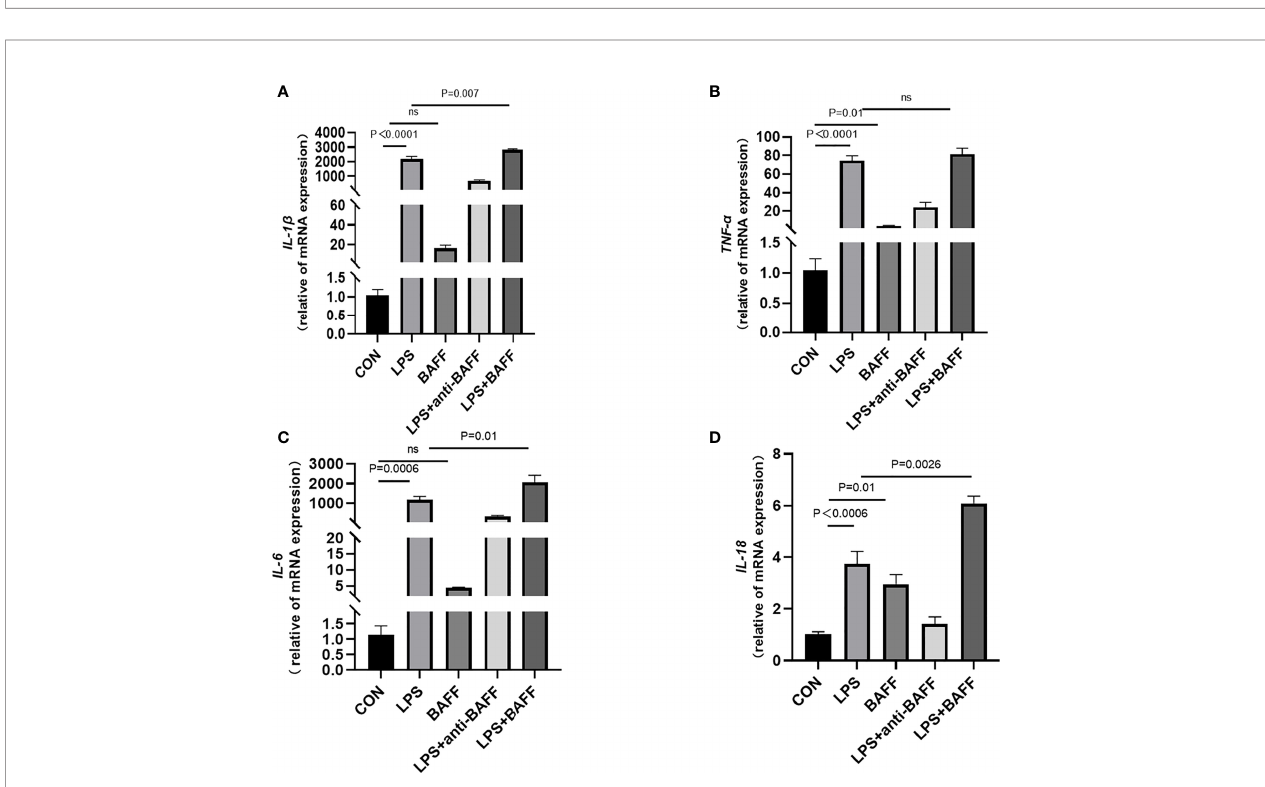
FIGURE 10 | LPS synergizes with BAFF to promote RAW264.7 cells in fl ammatory cytokines secretion. RAW264.7 cells were primed with LPS (1 ug/ml) for 6 h. Anti-BAFF antibody or mouse immunoglobulin G1 (IgG1) isotype control antibody at 1 ug/ml, recombinant mouse BAFF at 250 ng/ml in the presence of LPS 1 ug/ml for 6 h. (A – D) The mRNA level of IL-1 b , TNF- a , IL-6, and IL-18 was measured by RT-qPCR. ns, P >